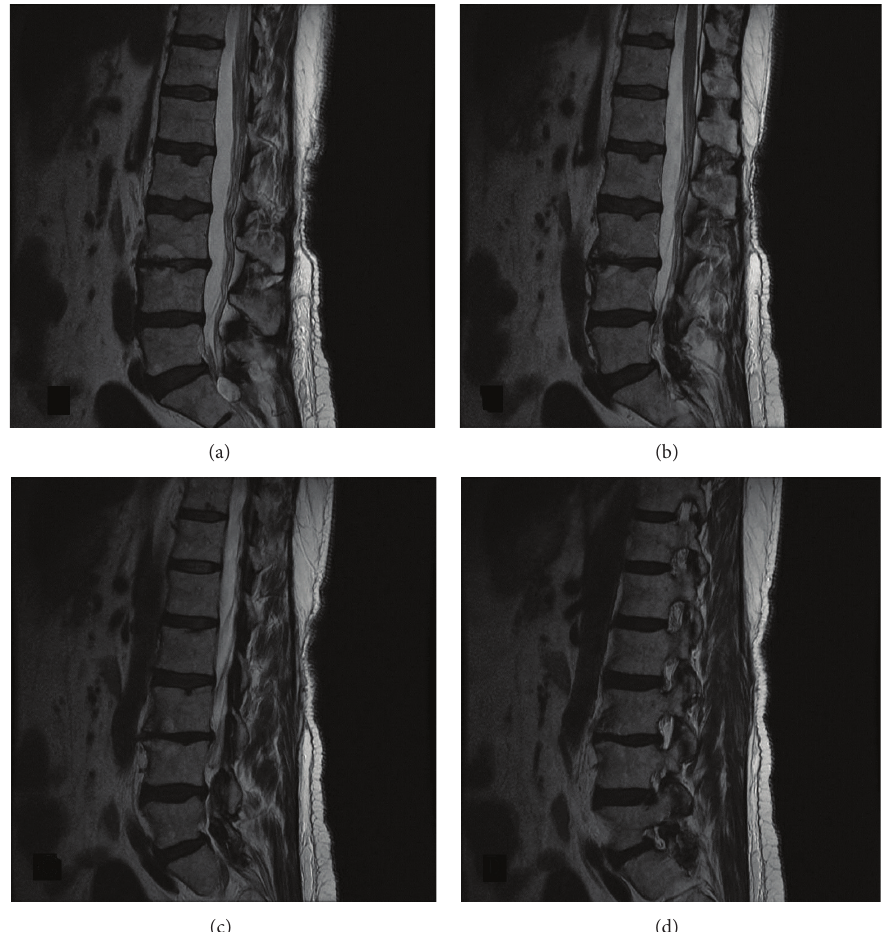
Figure 3: Sagittal T2-weighted MRI images showing sequential cuts ((a)–(d)) from midline to the foramen revealing the intrasacral mass separate from the left L5-S1 joint.